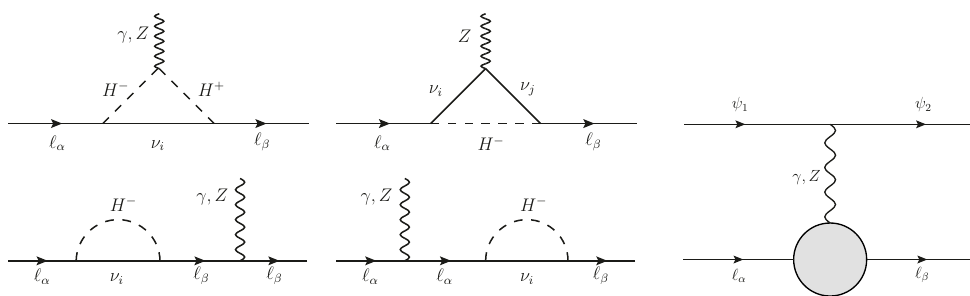
Figure 10 . γ and Z -penguin diagrams contributing to radiative decays ‘ α → ‘ β γ and Z → , respectively. Although only the H ± loop contributions are presented, similar diagrams with ‘ ± ‘ ∓ α β W ± / G ± were also considered in the calculations. On the right, we show the penguin-diagram topology for ‘ − ( ψ = ψ = ‘ + = ‘ − ) and µ − e conversion in nuclei ( ψ → ‘ − ‘ + ‘ − 1 2 α γ γ β δ δ